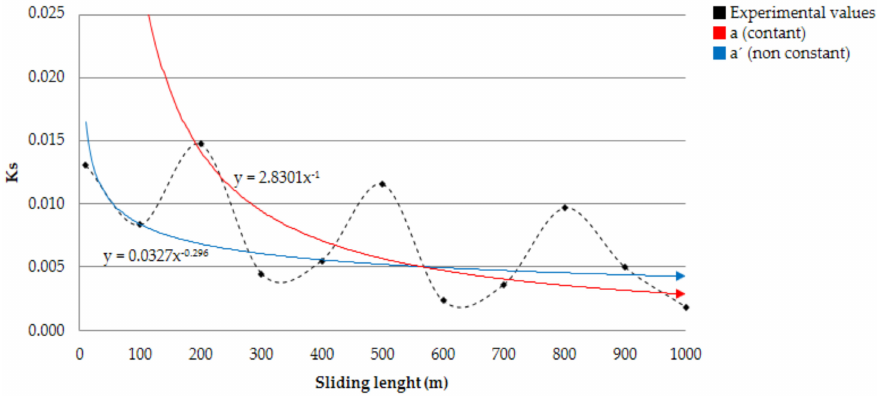
Figure 10. Archard wear coefficient vs. sliding distance.